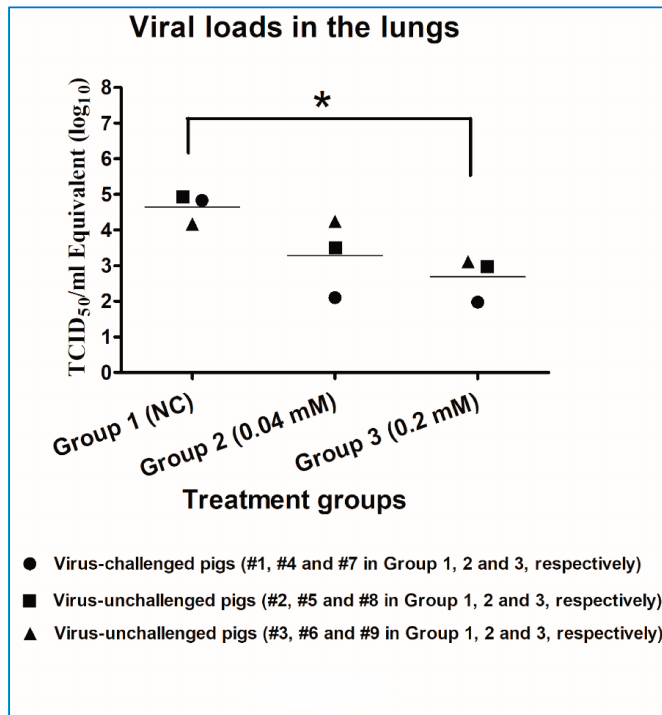
Figure 6. Quantification of residual viral loads in lung tissues collected from pigs in each group at 28 dpc. Viral RNA was extracted from the lung, and viral loads in the lung tissues were quantified by qRT-PCR. The viral loads in lung tissues were measured and expressed as TCID 50 /mL equivalents based on the standard curve of the Ct number plotted against the known virus titer of VR2332. Asterisks indicate significant differences (* p < 0.05) in virus titers between